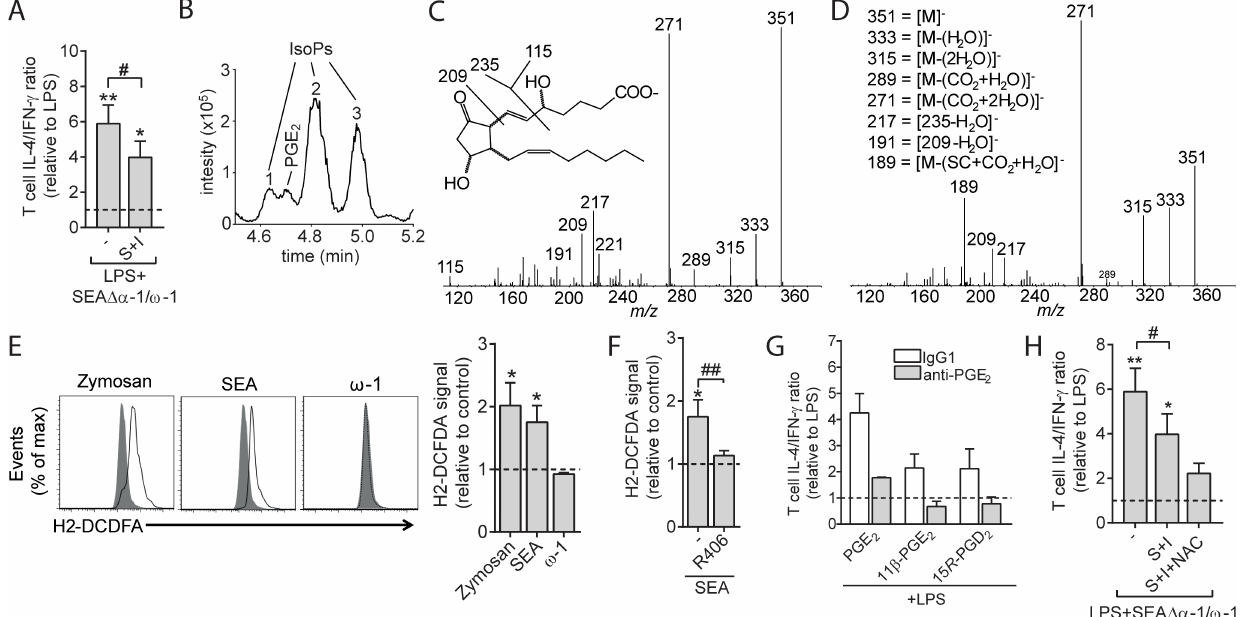
Fig 5. SEA-induced ROS production by moDCs results in PGE 2 isomer synthesis that contributes to Th2 polarization. (A) T-cell polarization assay as described in Fig 2A in the presence of COX inhibitors S and I. Bars represent mean ± SEM of at least 3 independent experiments. (B) LC-MS/MS trace showing the transition m/z 351 ! 271; the detected IsoPs are indicated by numbers. (C) Tandem MS spectrumof isomer 2, showing the fragment ion m/z 189, characteristic for 15-series IsoPs. (D) Showing the MS/MS spectrum of isomer 3, possibly identifying this isomer as a 5-series IsoP, based on the fragment ions m/z 115, 217, and 191. (E) ROS generation was determined by flow cytometry (H2-DCFDA) of moDCs pulsed for 6 h with indicated reagents. On the left, representative histograms for ROS induction are shown. On the right, the geometric mean fluorescence of these signals is enumerated and shown as fold change relative to unstimulated moDCs (dashed line set to 1). (F) ROS production was quantified as in panel E following pretreatment with general ROS scavenger NAC or R406 for 1 h. (G) moDCs were stimulated with indicated PGs with or without anti-PGE 2 after which a T-cell polarization assay was performed as described in Fig 2A.(H) moDCs were stimulated with indicated reagents in the presence following 1 h pre-incubation with COX inhibitors (S and I) and NAC after which a T-cell polarization assay was performed as described in Fig 2A.Bars represent mean ± SEM of at least 3 independent experiments. “ (cid:3) ” and “#”: P < 0.05: “ (cid:3)(cid:3) ” and “#”: P < 0.01 for significant differences with the LPS control ( (cid:3) ) or between-test conditions (#) based on paired analysis (paired Student t test). Underlying data can be found in S1 Data.COX, cyclooxygenase; H2-DCFDA, 2’,7’-dichlorodihydrofluorescein diacetate; I, indomethacin; IsoP, isoprostane; LC-MS/MS, liquid chromatography tandem mass spectrometry; LPS, lipopolysaccharide; moDC, monocyte-derived DC; NAC, N -acetyl- L -cysteine; PGE 2 , prostaglandin E 2 ; ROS, reactive oxygen species; S, SC236;SEA, soluble egg antigen; Th2, T helper